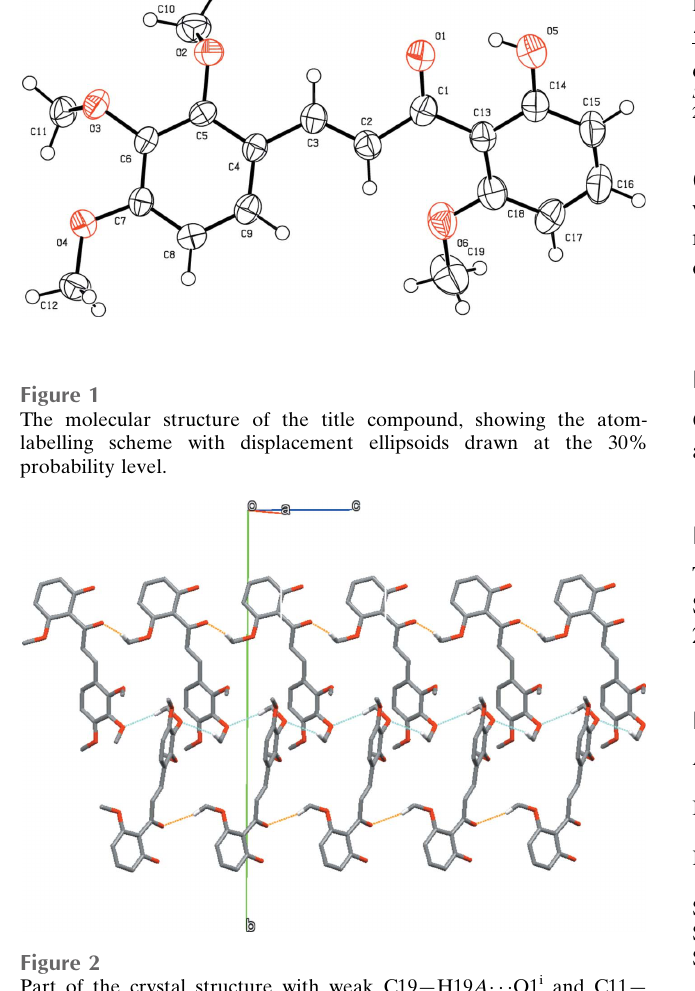
Figure 2 Part of the crystal structure with weak C19—H19 A (cid:3)(cid:3)(cid:3) O1 i and C11— H11 A (cid:3)(cid:3)(cid:3) O ii hydrogen bonds shown as orange and blue dashed lines, respectively. For clarity only those H atoms involved in hydrogen bonding are shown.